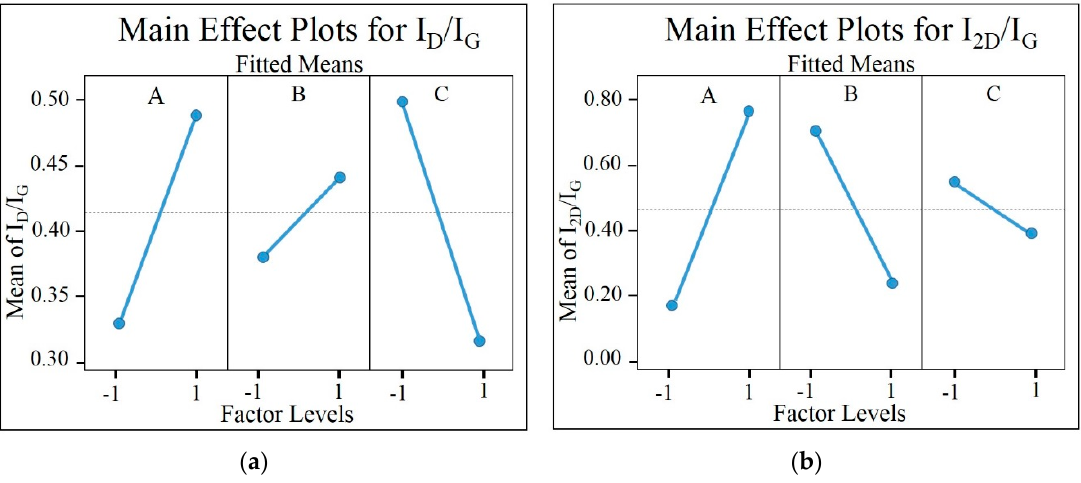
Figure 2. Main effect plots of the factors “A”, “B” and “C” for Response I ( a ) and Response II ( b ). All of the factors seem to show the main effect on both